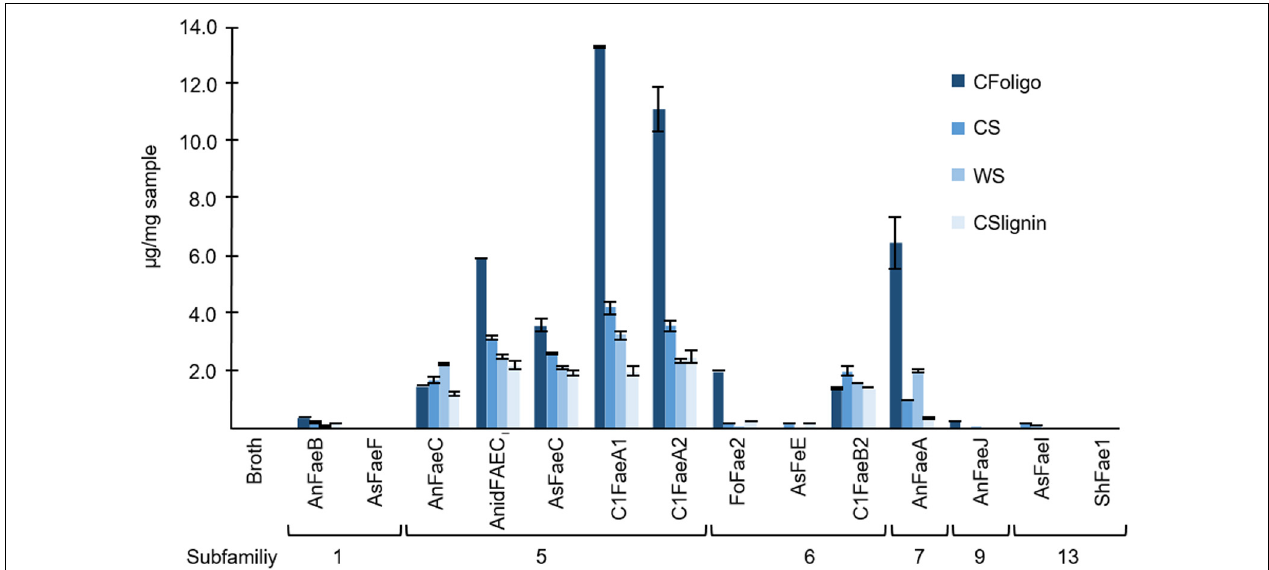
FIGURE 7 | The release of the diFA corresponding to a m/z value of 401 10 . 66 min . The release of this diFA ( µ g of compound/mg dry matter of natural substrate) from corn fiber oligomers (CFoligo), corn stover (CS), wheat straw (WS), and corn stover lignin isolate (CSlignin) that were incubated with and without (broth) FAEs at 37 ◦ C for 19 h. Samples were measured by RP-UHPLC-UV-ESI-MS/MS ( n = 2). The broth is the culture supernatant of P. pastoris which was grown without FAE insertion (negative control). Error bars represent the average standard deviation based on determined absolute